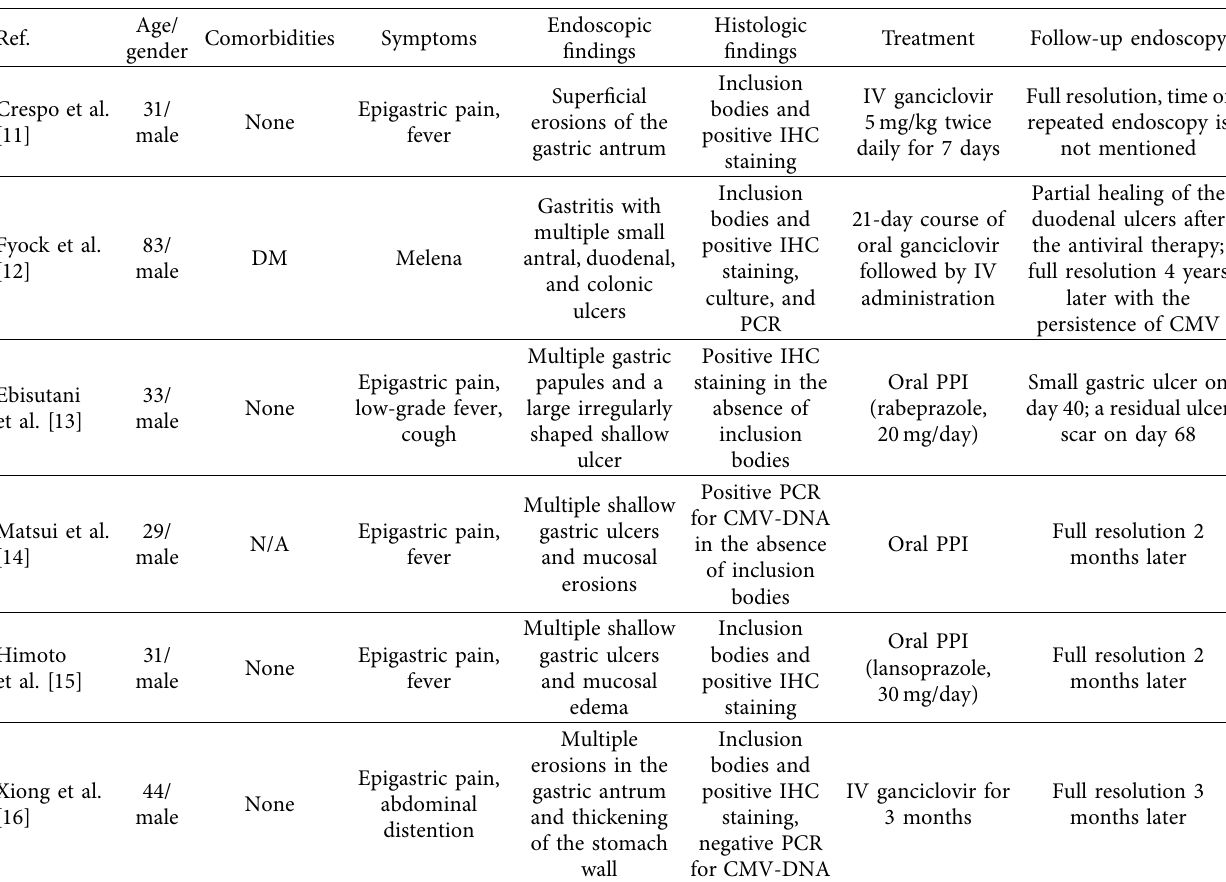
Table 1: Summary of published data from previous cases of gastric cytomegalovirus disease in immunocompetent patients. Ref.